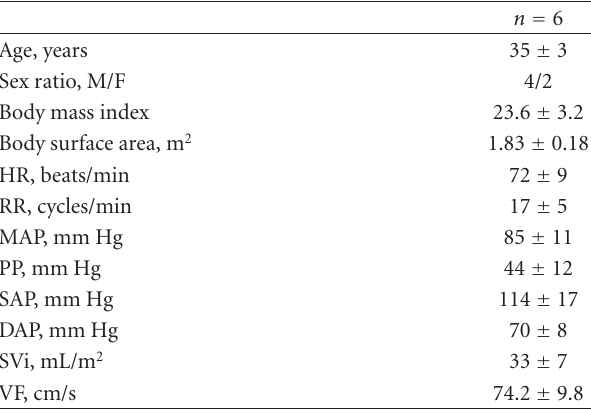
Table 1: Main characteristics of healthy